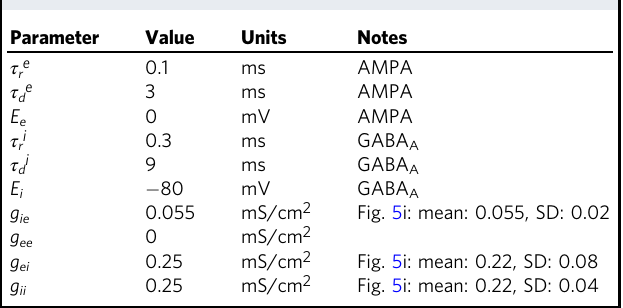
Table 3 Synaptic parameters used in simulating